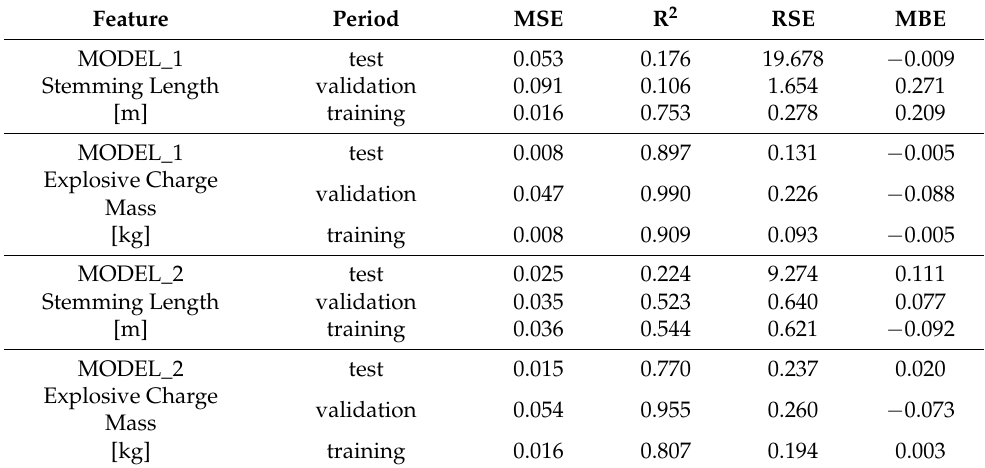
Figure 13. Model_2—Stemming length vs. volume of resulting borehole cavity. Table 2. Metric results of the predicted vs. observed Stemming Lengths and Explosive Charge Mass.